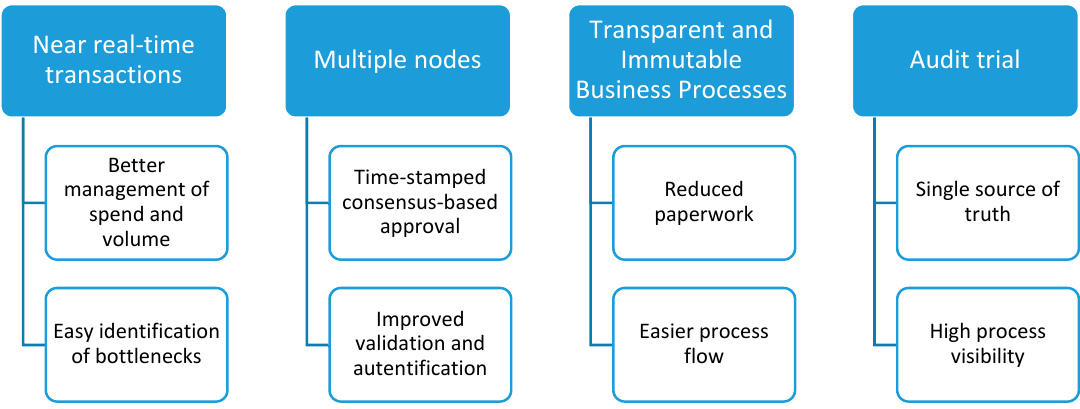
Figure 7. Benefits of blockchain technology. Source: Lakshmi and Sricharan, 2019, p. 1785 [29].